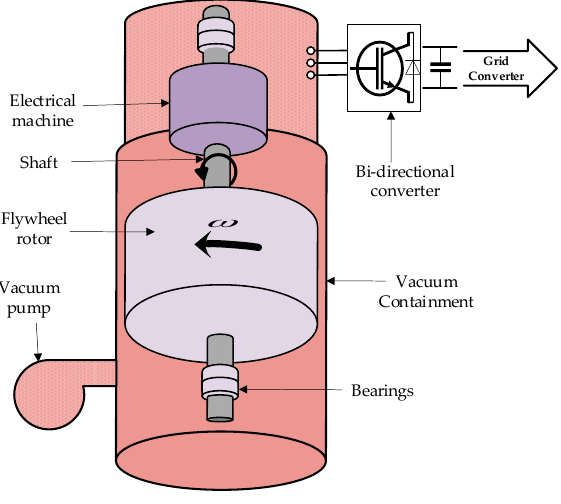
Figure 1. Structure of solid disk FESS.